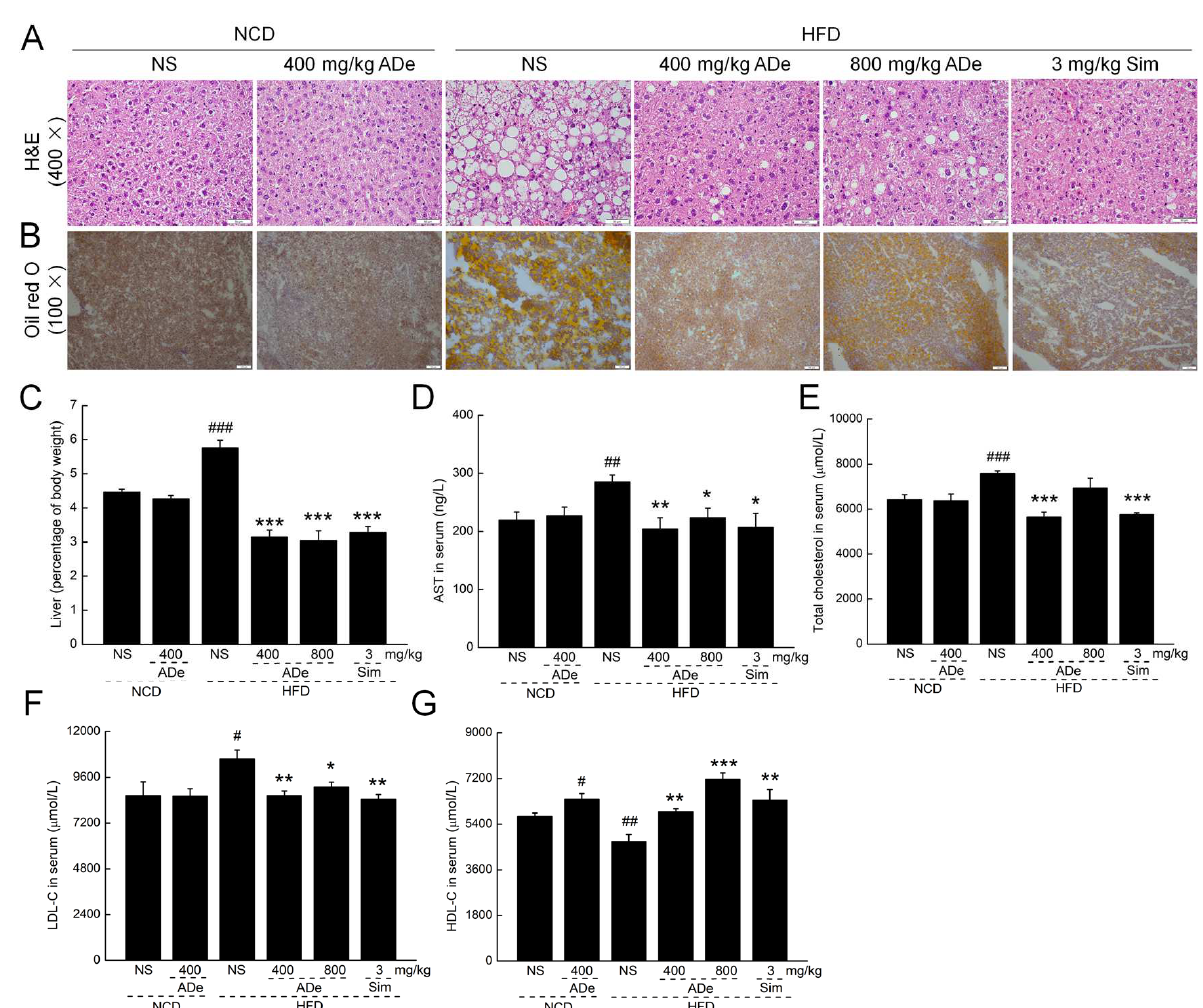
Figure 2. Effect of ADe treatment on the liver function. Histopathological analysis of the mouse livers after ( A ) H&E staining (200×; scale bar: 50 μm) and ( B ) Oil Red O staining (100×; scale bar: 100 μm). ADe decreased ( C ) the liver index, the serum levels of ( D ) AST, ( E ) total cholesterol, and ( F ) LDL-C, and increased the serum levels of ( G ) HDL-C (n = 6). # p < 0.05, ## p < 0.01, and ### p < 0.001 versus NCD-fed mice; * p < 0.05, ** p < 0.01, and *** p < 0.001 versus HFD-fed mice.